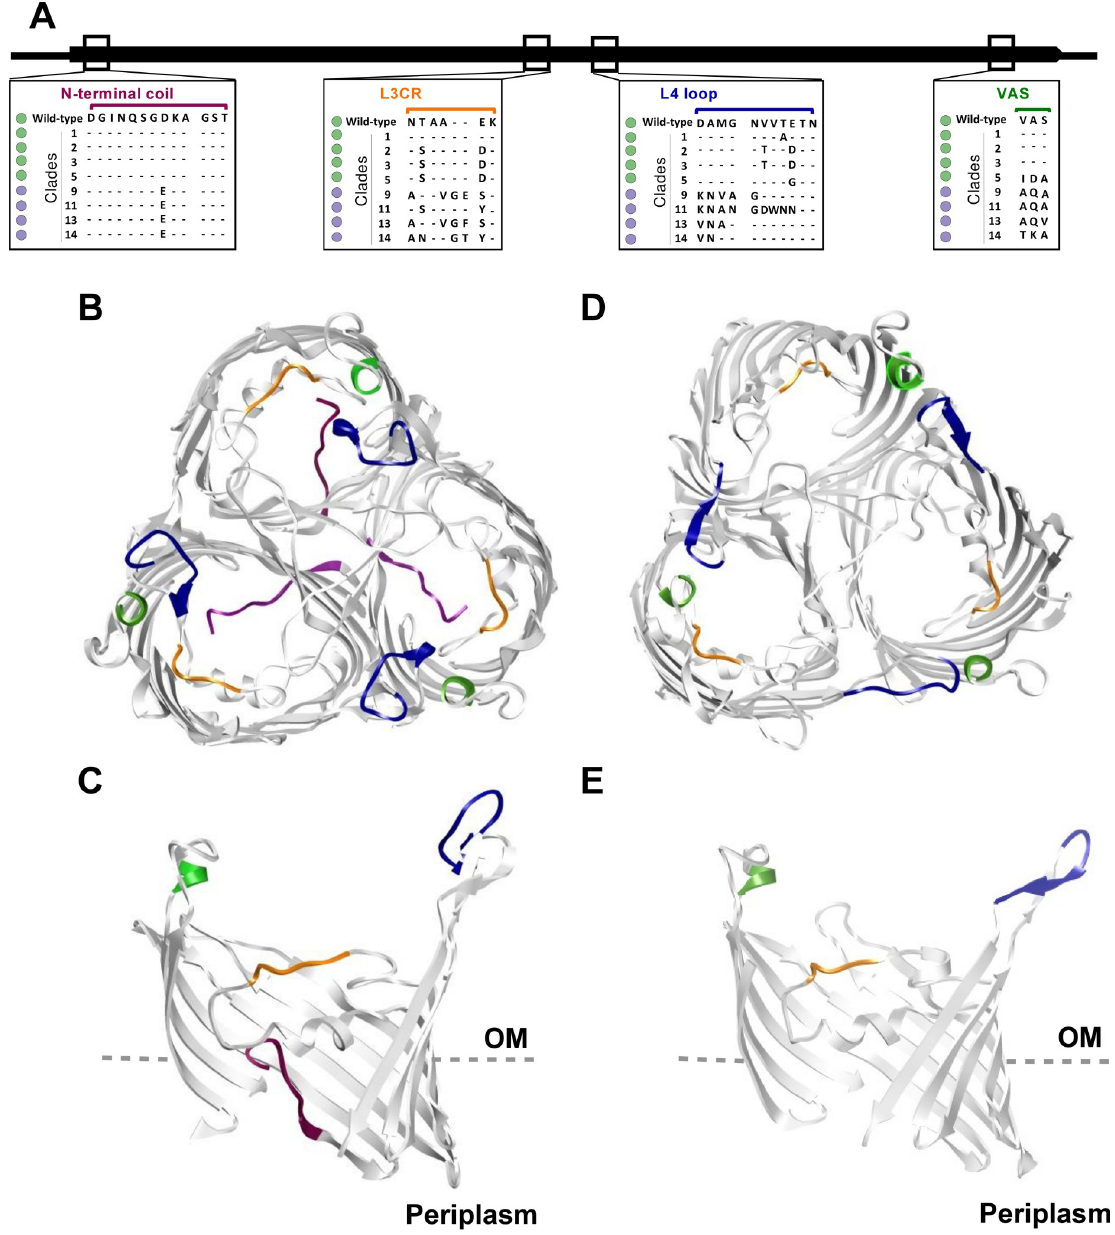
Fig 2. Comparative visualization of domains within OmpU associated with bile resistant phenotypes. (A). Multiple sequence alignment of ompU alleles resistant and sensitive to whole bile. Conserved residues are indicated by dots and those absent are indicated by gray boxes. (B-E) Comparative architecture of OmpU domains associated with the bile resistant phenotype. Domains are color coded and visualized in OmpU N16961 and GBE1114. Top and slabbed view of (B, C) N16961 and (D, E) GBE1114, respectively. The identified domains are colored as follows: NTC (purple), L3R (orange), L4 (blue) and VAS (green).